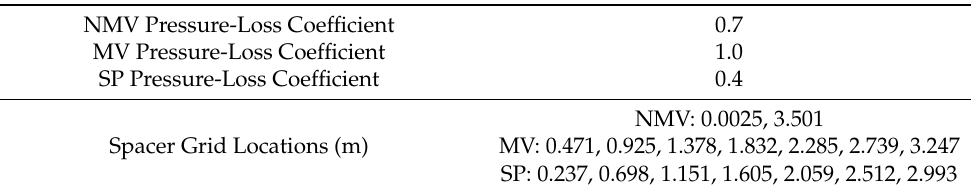
Table 3. 5 × 5 spacer grids from the PSBT